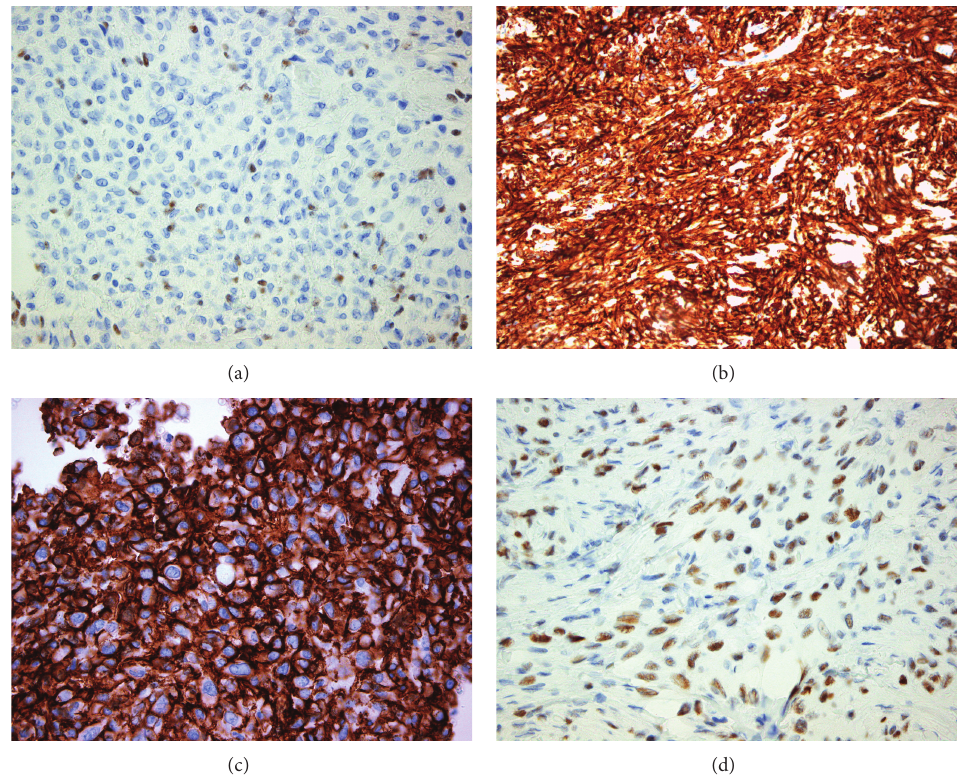
Figure 3: (a) Loss of protein INI1 in neoplastic cells. Endothelial cells retain positivity (IHC, × 400). (b) Ca 125 expression (IHC, × 400). (c) Podoplanin expression (IHC, × 400). (d) TLE-1 expression (IHC, ×